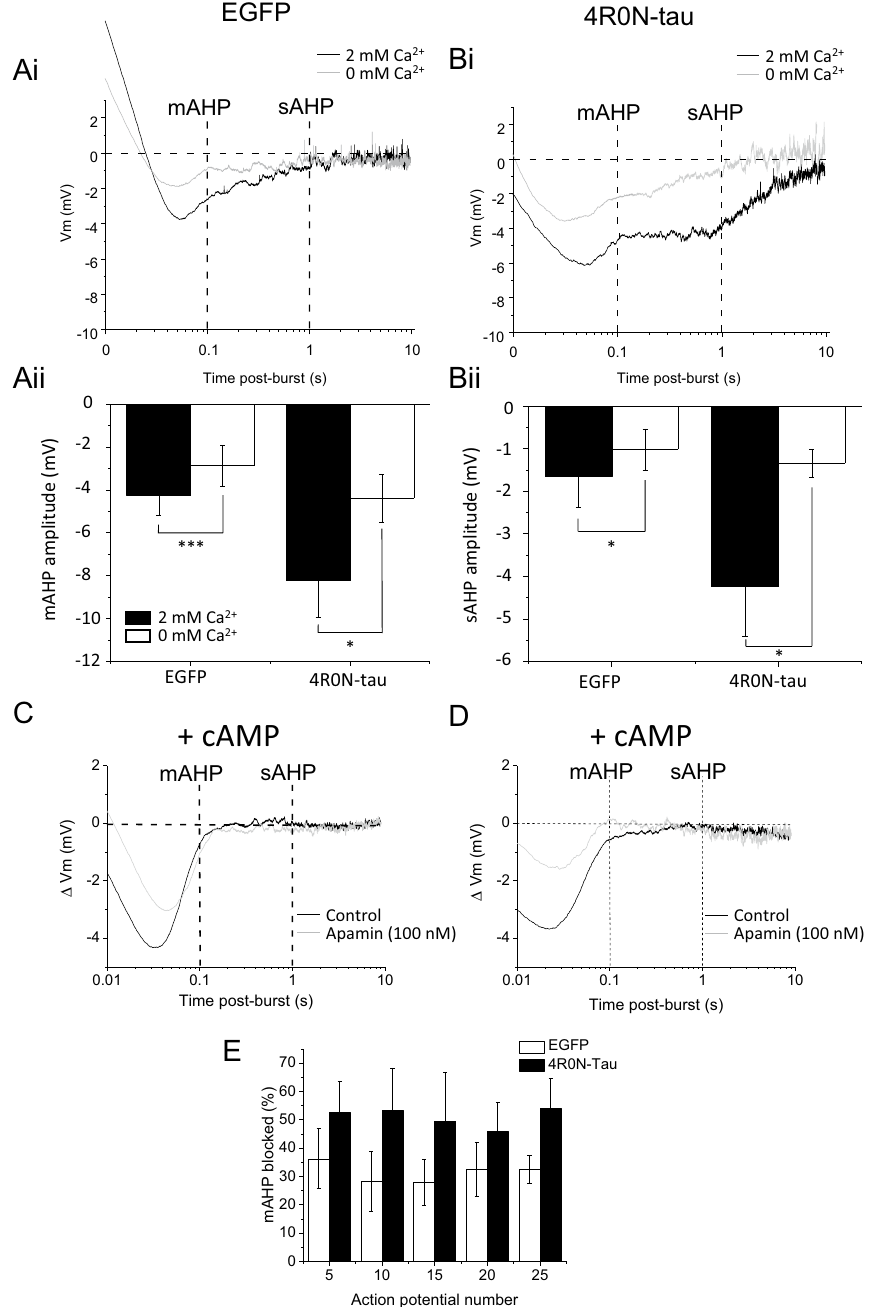
Figure 2. Ca 2+ -dependent components of hippocampal CA1 pyramidal cell AHPs are enhanced by expression of 4R0N-tau. Removal of extracellular Ca 2+ reduced the amplitude of the medium AHP and abolished the slow AHP in both neurons expressing EGFP alone ( Ai ) and 4R0N-tau ( Bi ). Black traces are control and the gray traces are in the absence of extracellular Ca 2+ . The reduction in amplitude of both the medium AHP ( Aii ) and the slow AHP ( Bii ) is greater in those CA1 neurons expressing 4R0N-tau compared with expressing EGFP alone. ( C , D ) Membrane voltage traces of AHP evoked following a train of 15 action potentials (evoked by 2 nA, 2 ms duration current injections delivered at 50 Hz) displayed on a log 10 time base from cells dialysed with cAMP (1 mM) to abolish the slow AHP in neurons expressing EGFP alone ( C ) or 4R0N-tau ( D ). Application of apamin (100 nM) to inhibit the SK channel-dependent component of the medium AHP produced a larger suppression of the medium AHP (gray traces) in neurons expressing 4R0N-tau ( D ) compared with EGFP alone ( C ). ( E ) The amount of the medium AHP that was blocked by apamin was independent of the number of action potentials used to evoke the slow afterpotential. Plotted are means ± s.e.m. p ≤ 0.05, ** p ≤